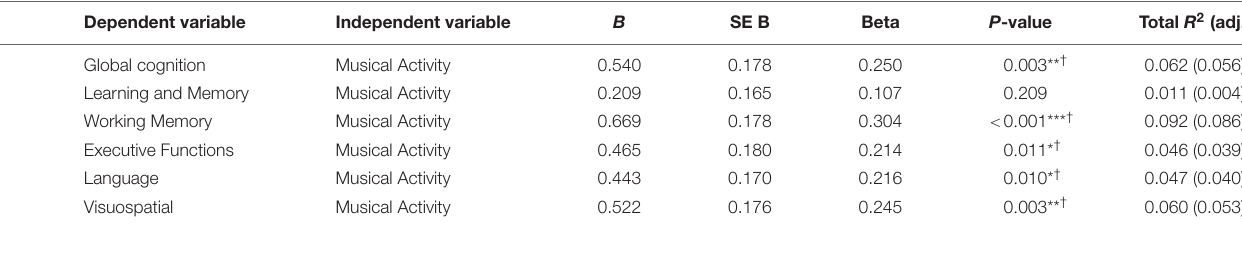
TABLE 2 | Results of linear regression analyses between musical activity and